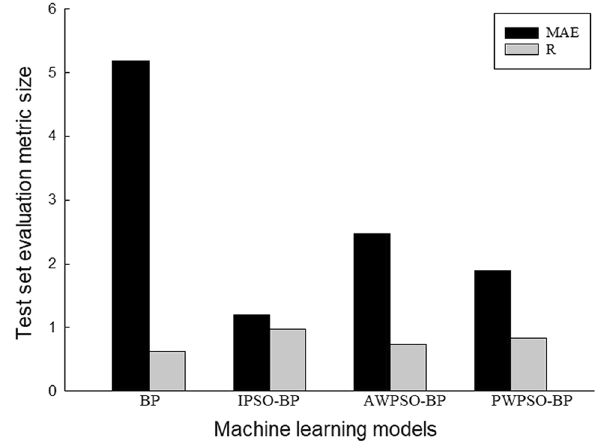
Figure 17. Performance evaluation index of the algorithm model of the right test set.